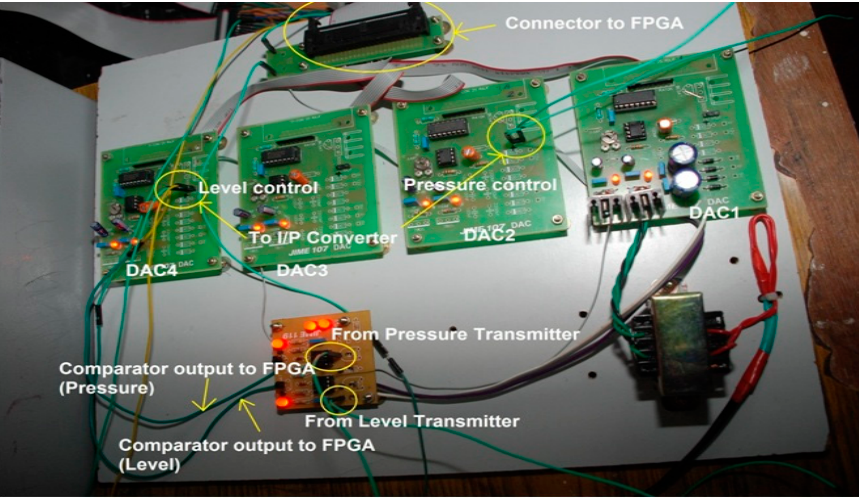
Figure 9. Interface board for ADC conversion, DAC output to I/P converter. DAC1 and DAC2 are used for the pressure process station, and DAC3 and DAC4 are used for the level process station. The outputs of comparators and inputs to the DACs are integrated into a single 50-pin connector so that the other end of the connector can be connected to the FPGA board (XC3S200). This board has one 40 pin connector, three 25 pin connectors, and one universal asynchronous receiver transmitter (UART) connector. Additionally, it has eight switches and eight light emitting diodes